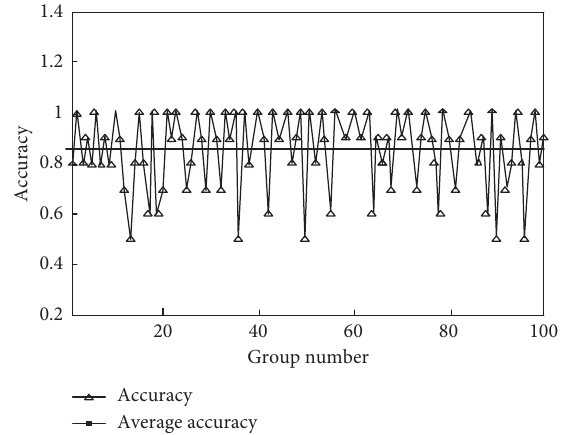
Figure 5: Distribution of user recognition accuracy in the top 1000.